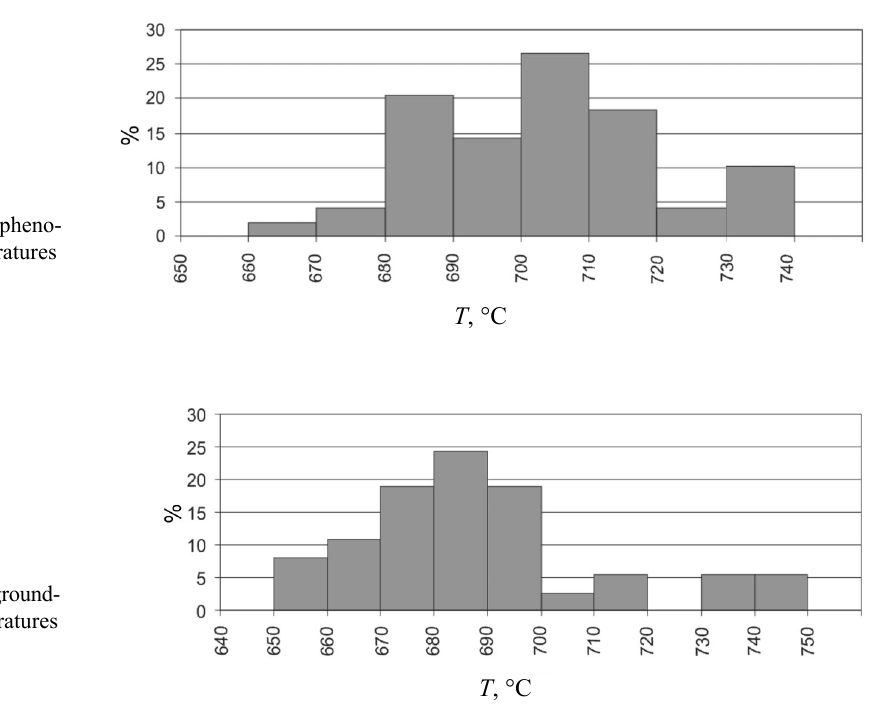
Fig. 5. Percentage distribution of pheno- cryst quartz crystallization temperatures in the Suursaari quartz porphyry.